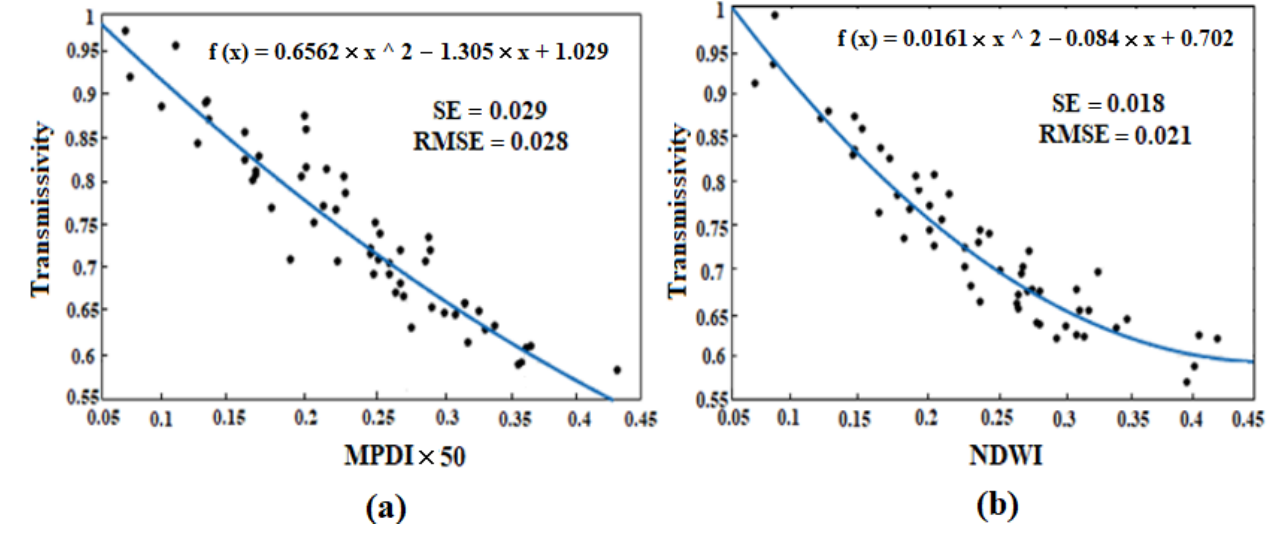
Figure 4. Scatter plots of MPDI ( a ) and NDWI ( b ) versus transmissivity.